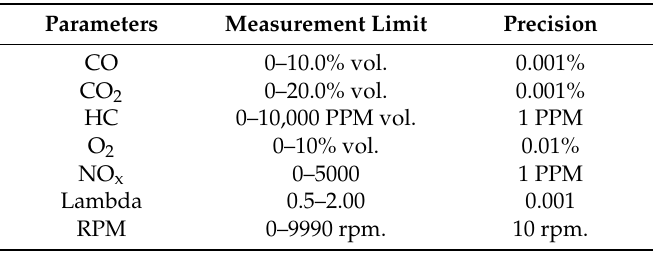
Table 4. Exhaust gas analyzer measurement